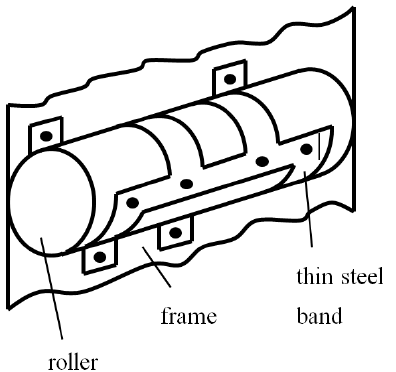
Figure 2. Practical realization of the rolling-link type mechanism.